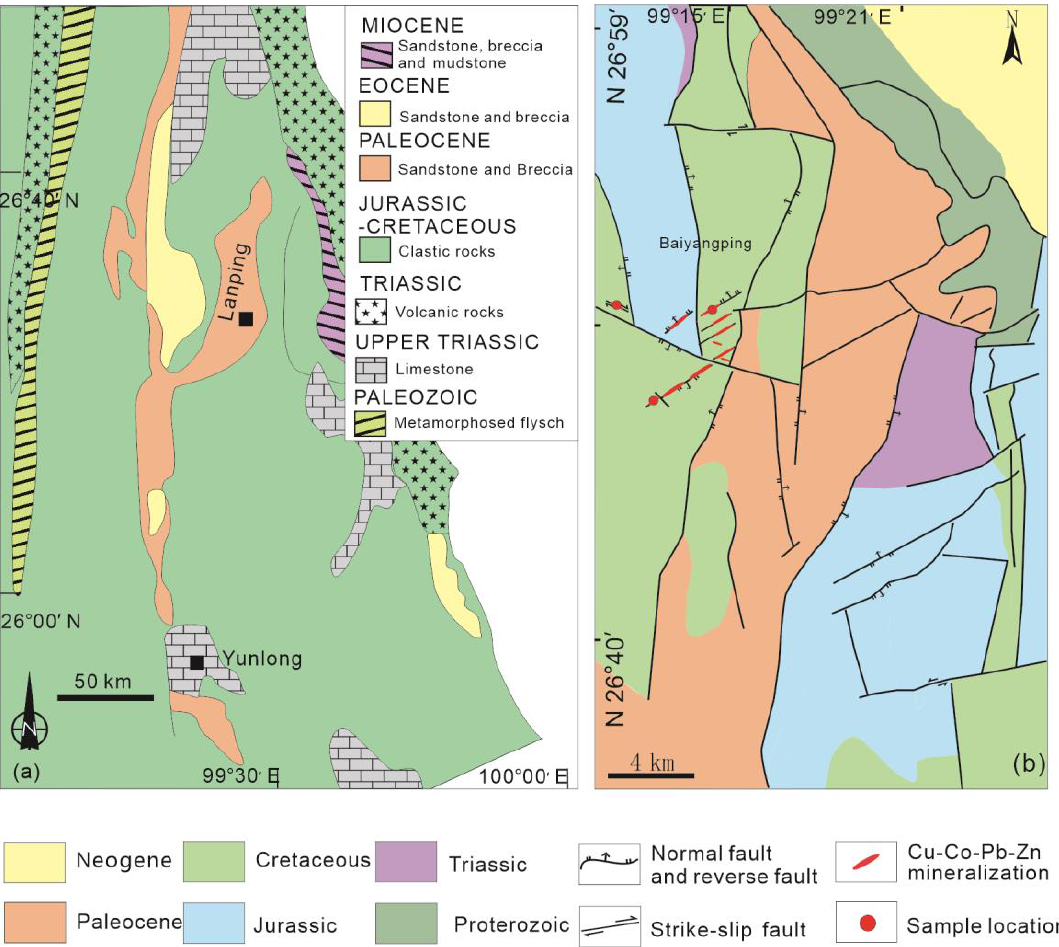
Figure 1. Simplified geological maps: ( a ) Lanping Basin; reprinted with permission from Ref. [9], 2018 Wiley. ( b ) Baiyangping Cu – Co – Pb – Zn deposit; reprinted with permission from Ref. [10], 2016 Wiley.